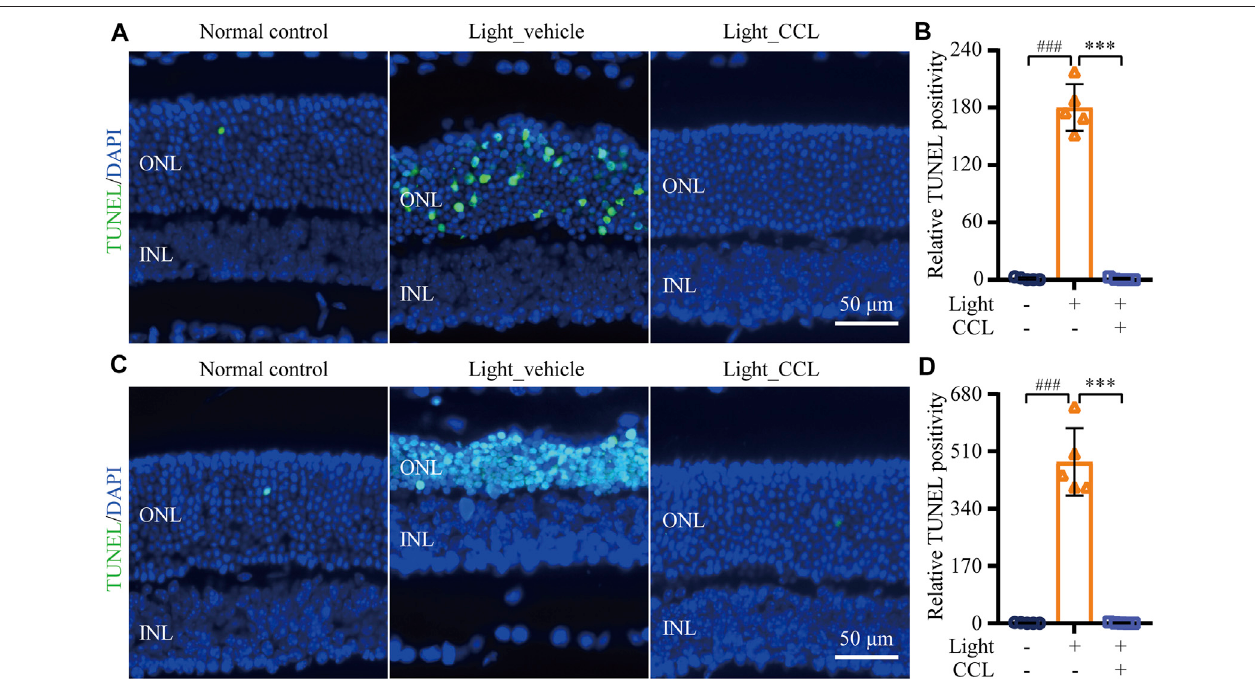
FIGURE 7 | CCL suppresses photoreceptor cell death in the light-exposed retinas. TUNEL assay was performed to assess photoreceptor cell death. Nuclei were stained by DAPI (in blue). TUNEL positivity (in green) in ONL was quanti fi ed by ImageJ. (A) Representative micrographs demonstrating TUNEL positivity from the eyes enucleated 24 h after light exposure. (B) The relative fold change in the TUNEL positivity from (A) was plotted against that from Normal control. (C) Representative micrographsdemonstratingTUNELpositivityfromtheeyesenucleated3 daysafterlightexposure. (D) TherelativefoldchangeintheTUNELpositivityfrom (C) was plotted against that from Normal control. INL, inner nuclear layer, ONL, outer nuclear layer. Scale bar, 50 μ m. Data were expressed as mean ± SD (n = 5 per group). ### Compared to Normal control, p < 0.001; *** compared to Light_vehicle, p < 0.001.